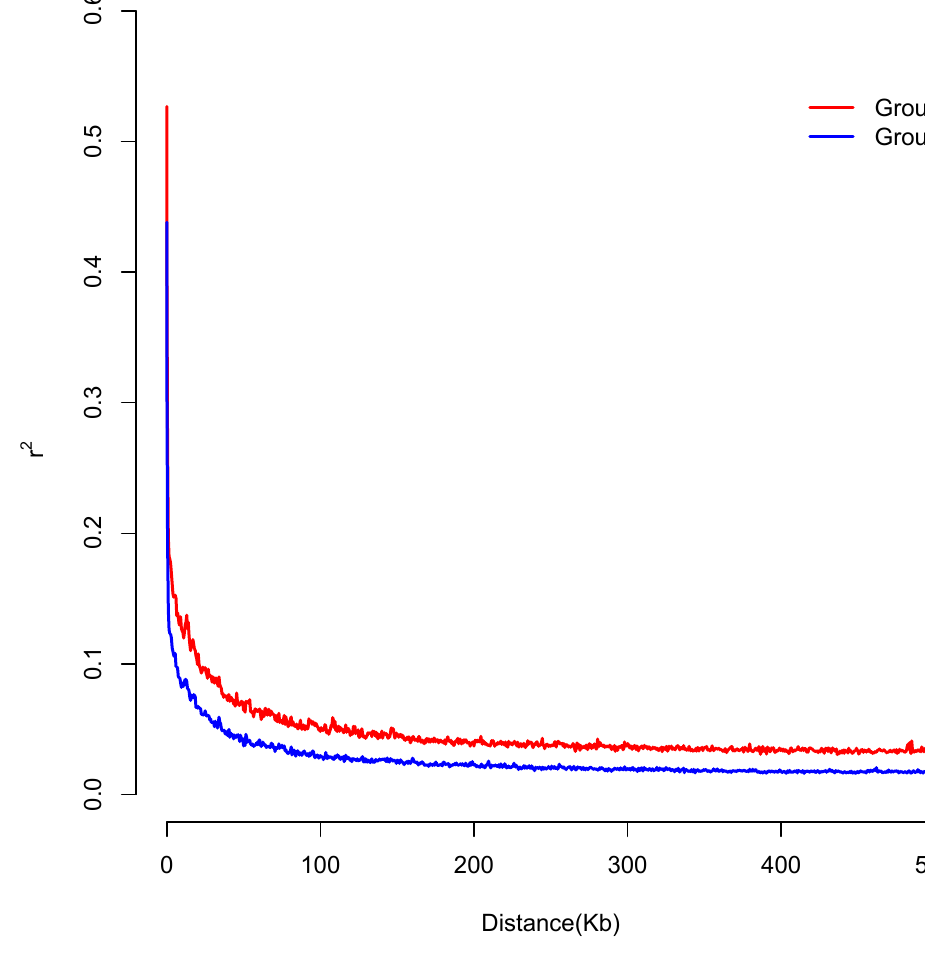
Figure 5. Linkage disequilibrium decay patterns of different D. catenatum